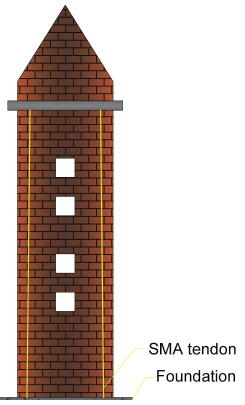
Figure 15. Installation of four pre-tensioned steel tie bars and SMA devices in the interior corners of the S. Giorgio church bell tower that were anchored to the foundation and the roof